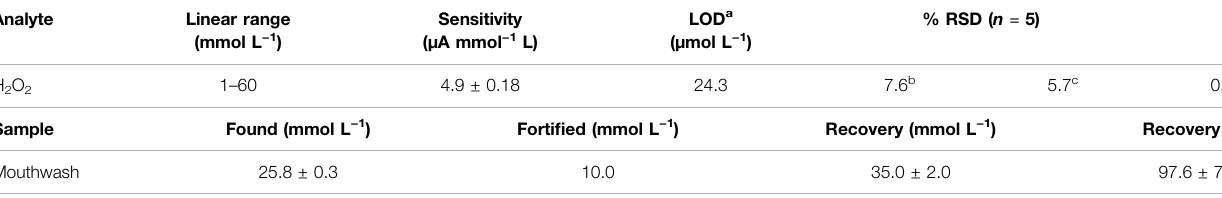
TABLE 2 | Analytical features obtained for determination of H 2 O 2 using BIA technique.